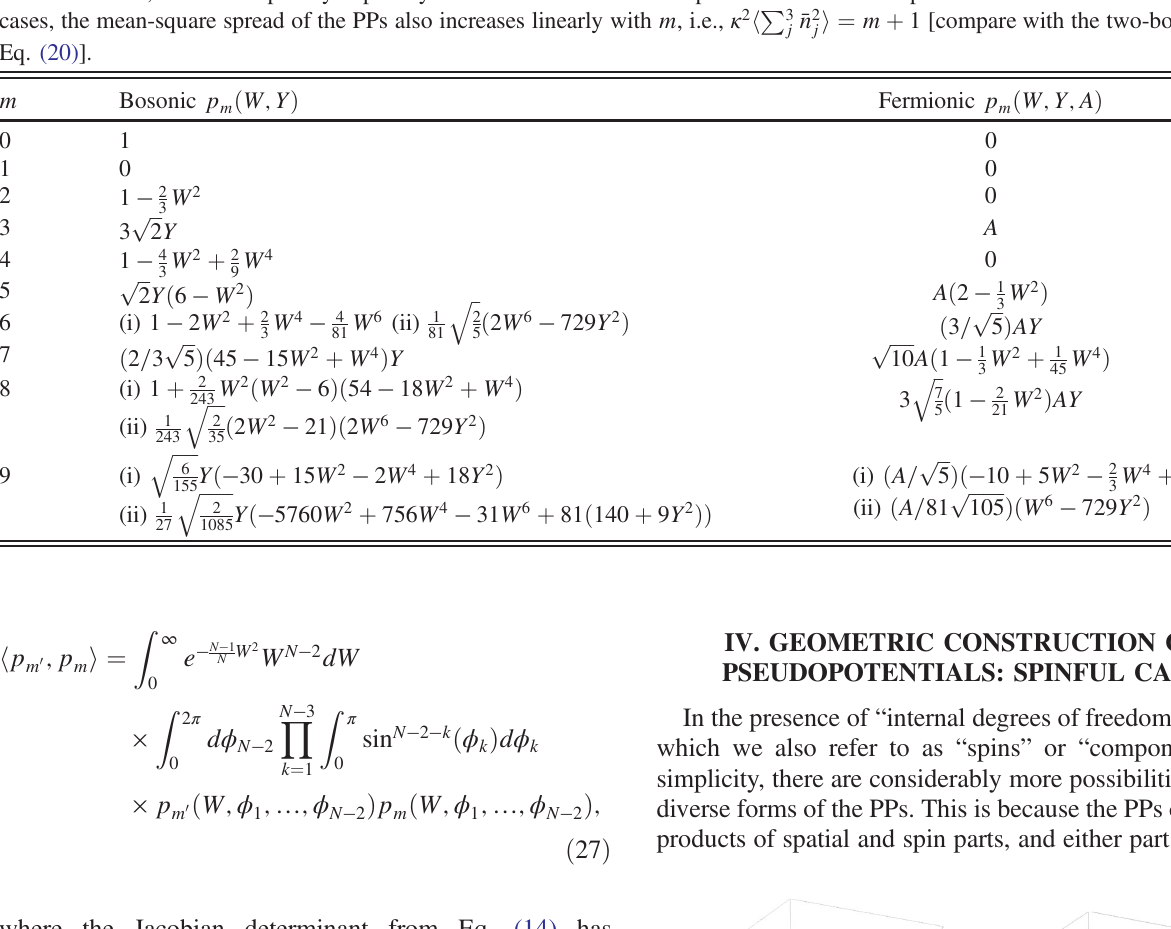
P 3 ¯ n 2 m þ 1 [compare with the two-body case in j j i ¼